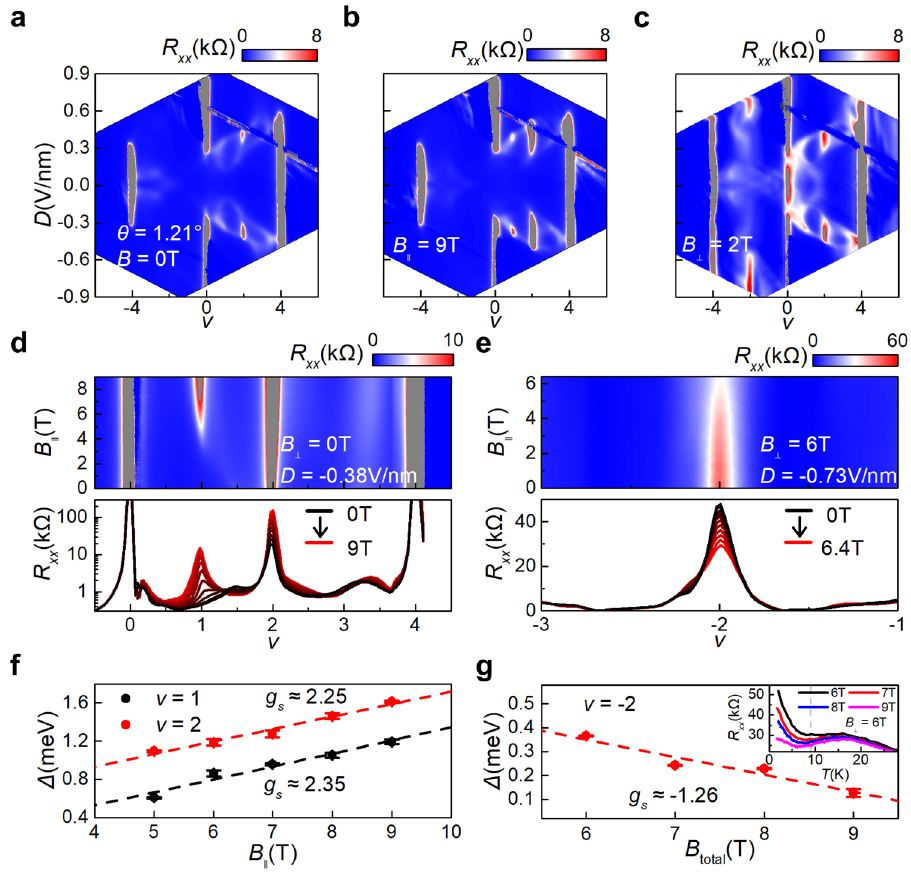
Fig. 2 Competition between spin and valley polarization. a – c Longitudinal resistance R xx as a function of fi lling factor v and displacement fi eld D of device D2 ( θ = 1.21°) at B = 0 T, B || = 9 T and B ⊥ = 2 T, respectively. d Top, longitudinal resistance R xx as a function of fi lling factor v and in-plane magnetic fi eld B || at D = − 0.38 V/nm. Bottom, line cuts of R xx ( v , B || ) from B || = 0 to B || = 9 T. e Top, longitudinal resistance R xx as a function of fi lling factor v and in-plane magnetic fi eld B || at D = 0.73 V/nm and B ? = 6 T. Bottom, line cuts of R xx ( v , B || ) from B || = 0 to B || = 6.4 T. f Thermal activation gaps versus B || at v = 1 and v = 2 corresponding to the insulating states in d . The spin g factor can be extracted from the linear fi tting with the spin Zeeman effect, 4 (cid:4) 2 ´ Sg s μ S = 1/2. g Thermal activation gaps versus total magnetic fi eld at v = − 2 corresponding to the insulating state in e . All Error bars are estimated according to the uncertainty at the thermal activation region. Inset, temperature dependence of R xx under the tilted magnetic fi eld. The perpendicular magnetic fi eld is fi xed at 6 T and B total increases from 6 T to 9 T.